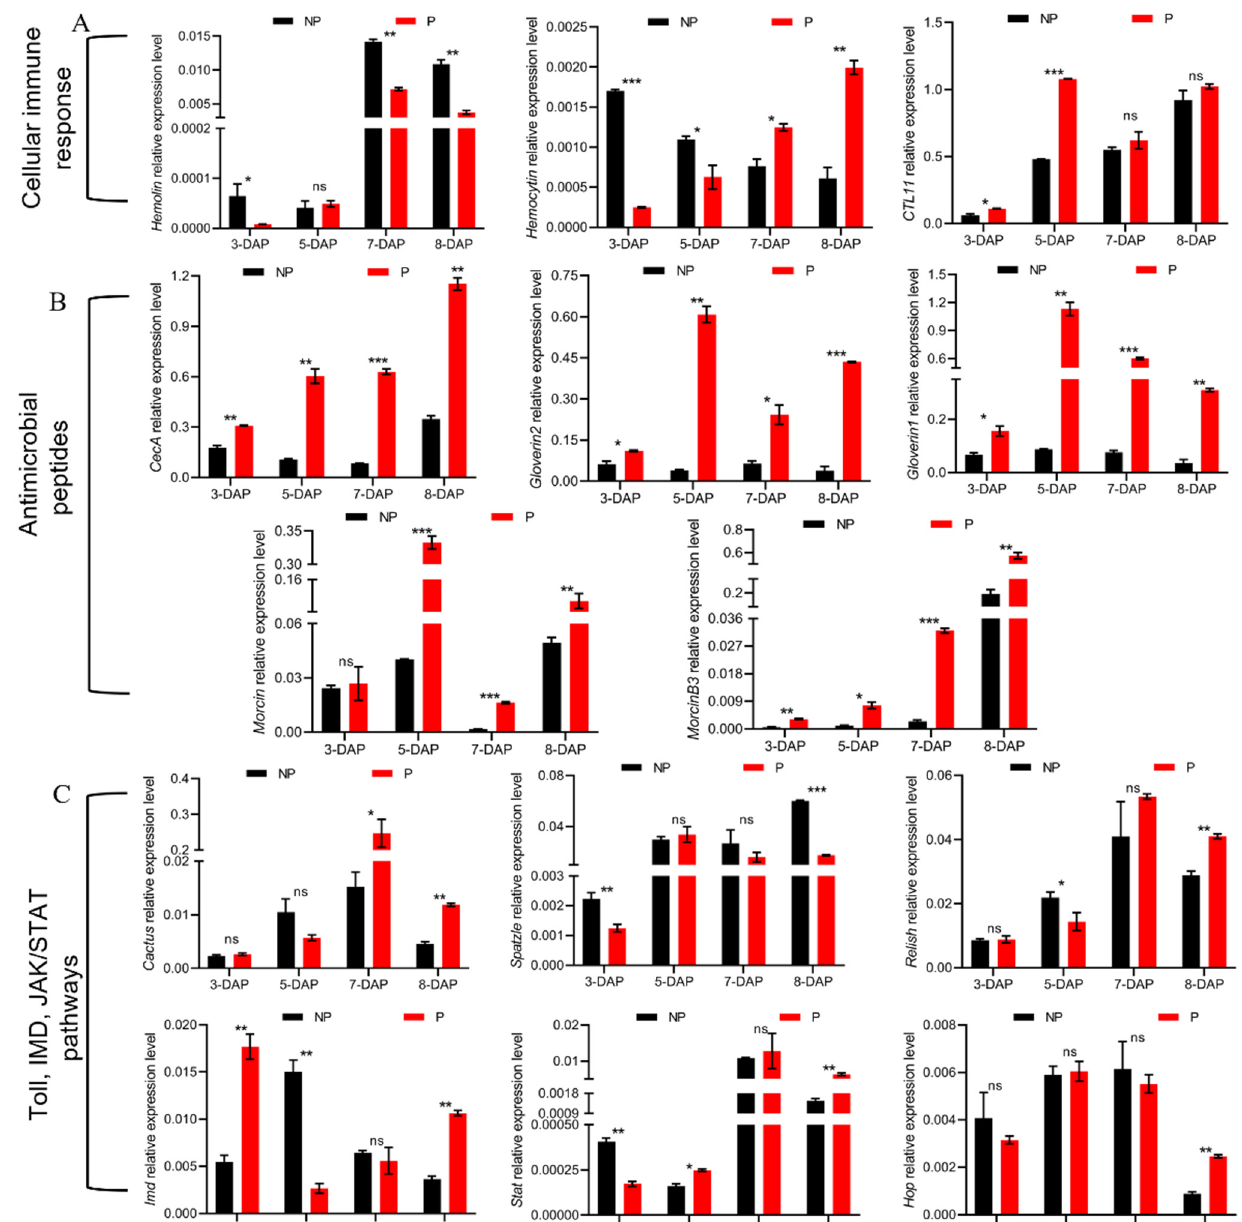
Figure 4. Transcriptional characteristics of immune-related genes induced by E. japonica parasitism. ( A ) The relative expression levels of cellular-immunity-related genes. ( B ) The relative expression levels of AMP genes. ( C ) The relative expression levels of Toll, IMD pathway genes and JAK/STAT pathway genes. All transcriptional levels were normalized to the expression level of Rp49 . The statistical significance is indicated by * p < 0.05, ** p < 0.01 or *** p < 0.001. The results are shown as the mean ± S.D.